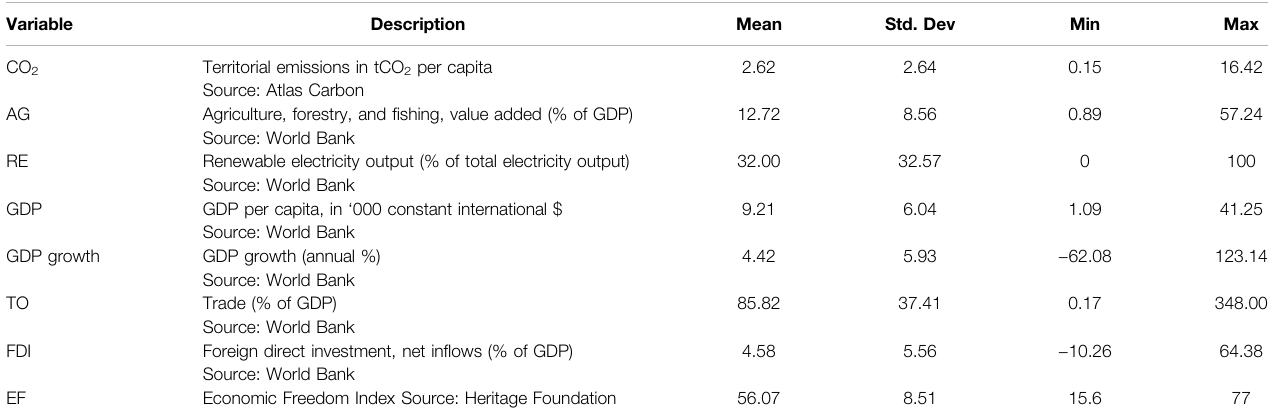
TABLE 1 | Descriptive statistics.